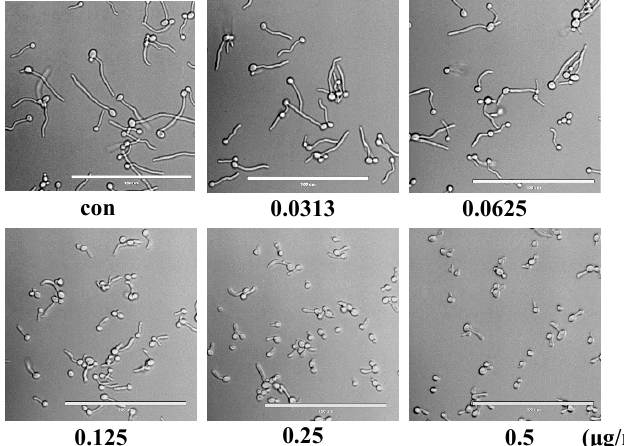
Figure 4. Anti-hyphae effects of different concentrations of compound 16g . The inhibition of 16g on the hypha formation of C. albicans . C. albicans SC5314 were incubated at 37 °C for 3 h in RPMI 1640 medium. The concentrations of 16g were ranged from 0.0313–0.5 μ g/mL. con: control.